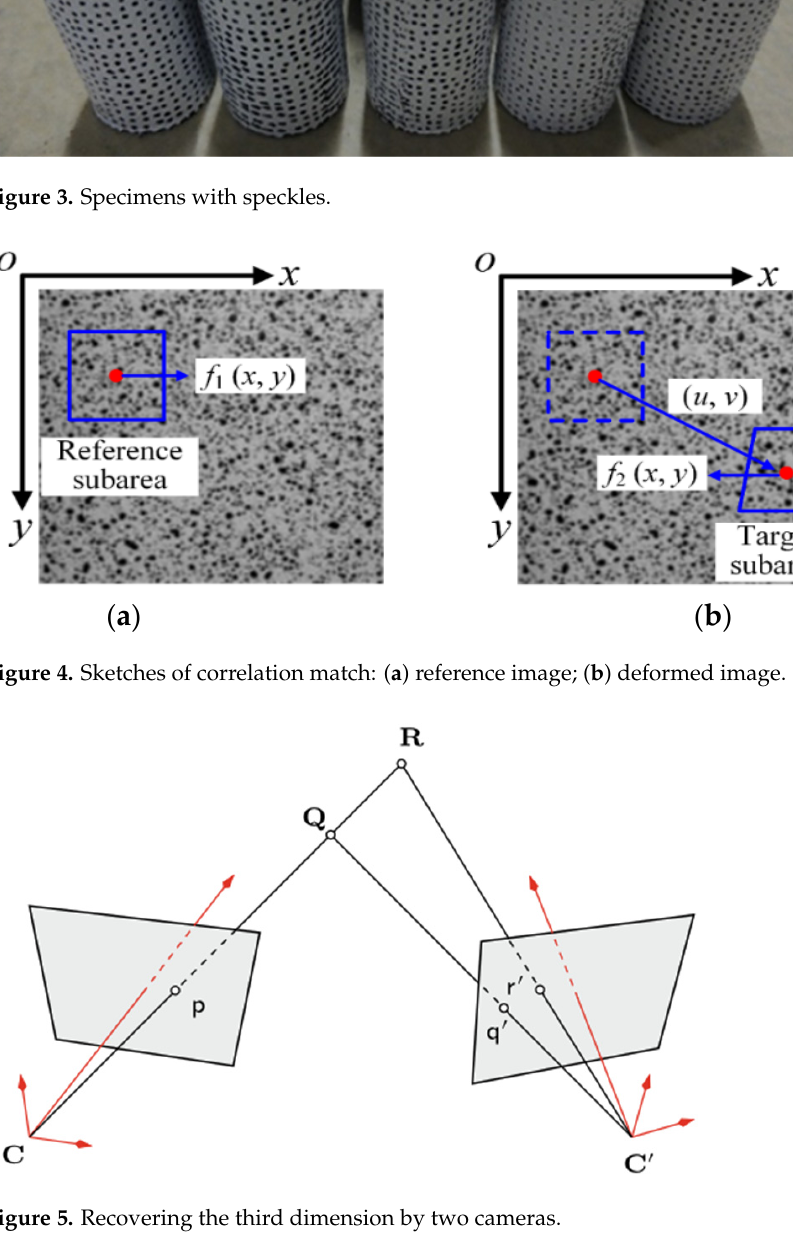
Figure 5. Recovering the third dimension by two cameras.